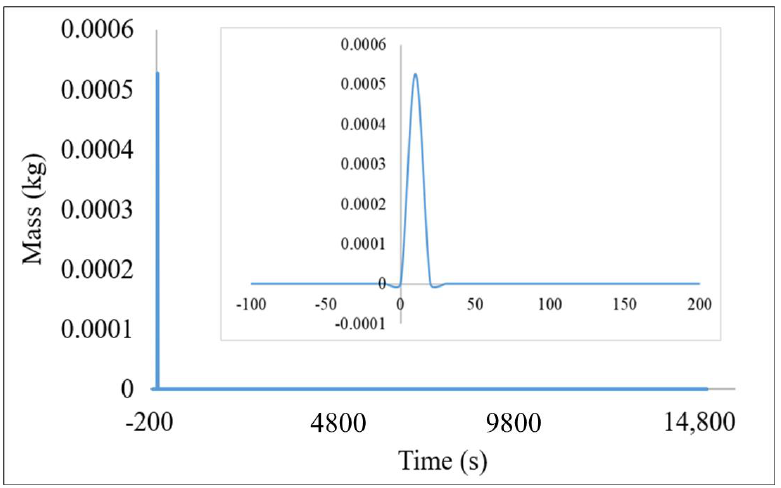
Figure 13. Cumulative hydrogen generation.